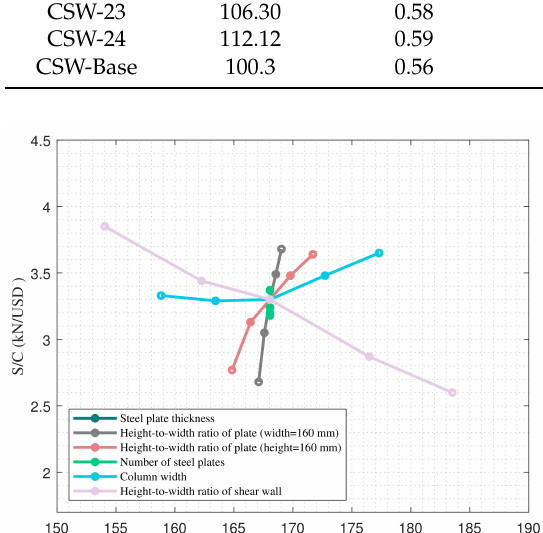
Figure 13. Normalised strengths for the different costs of configurations. The colour of each curve is associated with the variation of a design parameter as shown in the